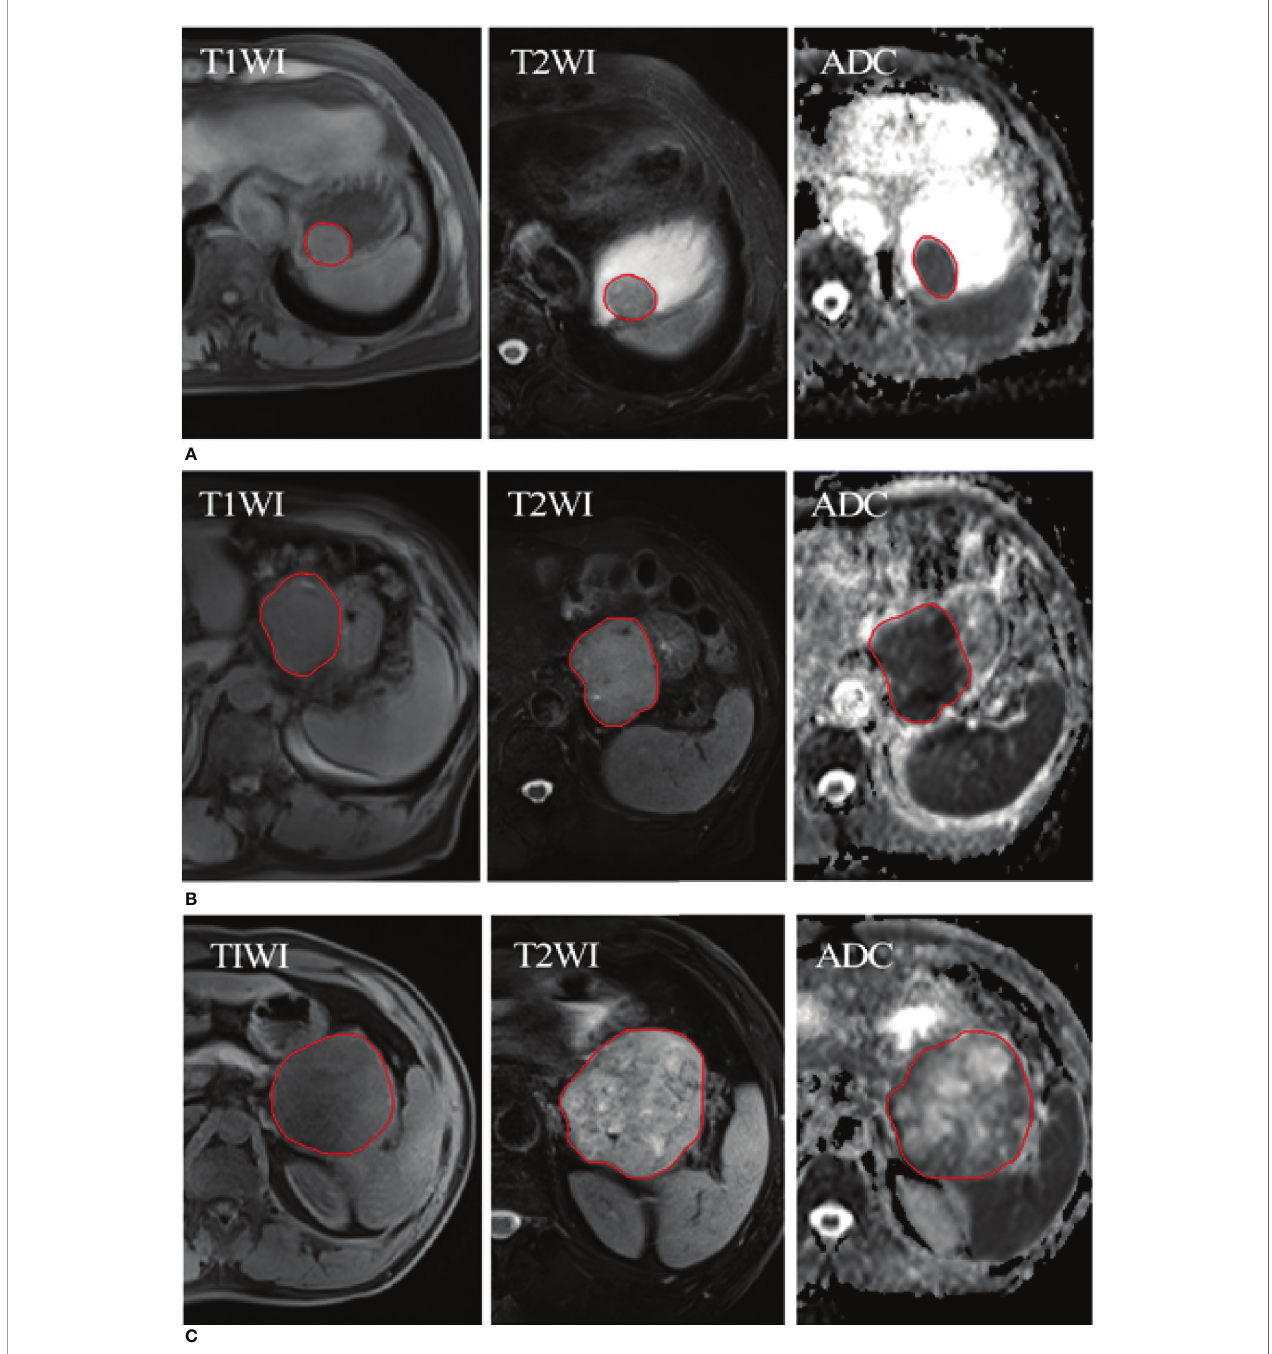
FIGURE 1 | ROI of three patients with different risk classi fi cation of GISTs. (A) Three MR sequences (T1WI, T2WI, and ADC) show a low-risk of GISTs in a 68-year- old woman. (B) Three MR sequences show a intermediate-risk of GISTs in a 78-year-old man. (C) Three MR sequences show a high-risk of GISTs in a 50-year-old man. The red circle represents the